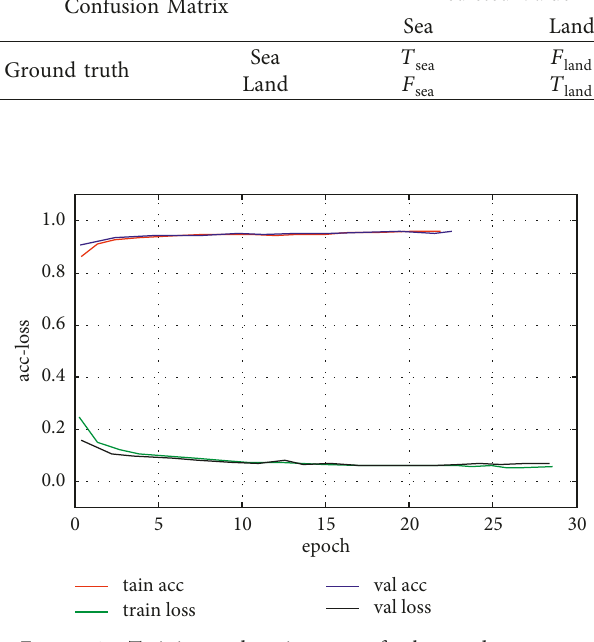
Figure 15: Training and testing curve for loss and